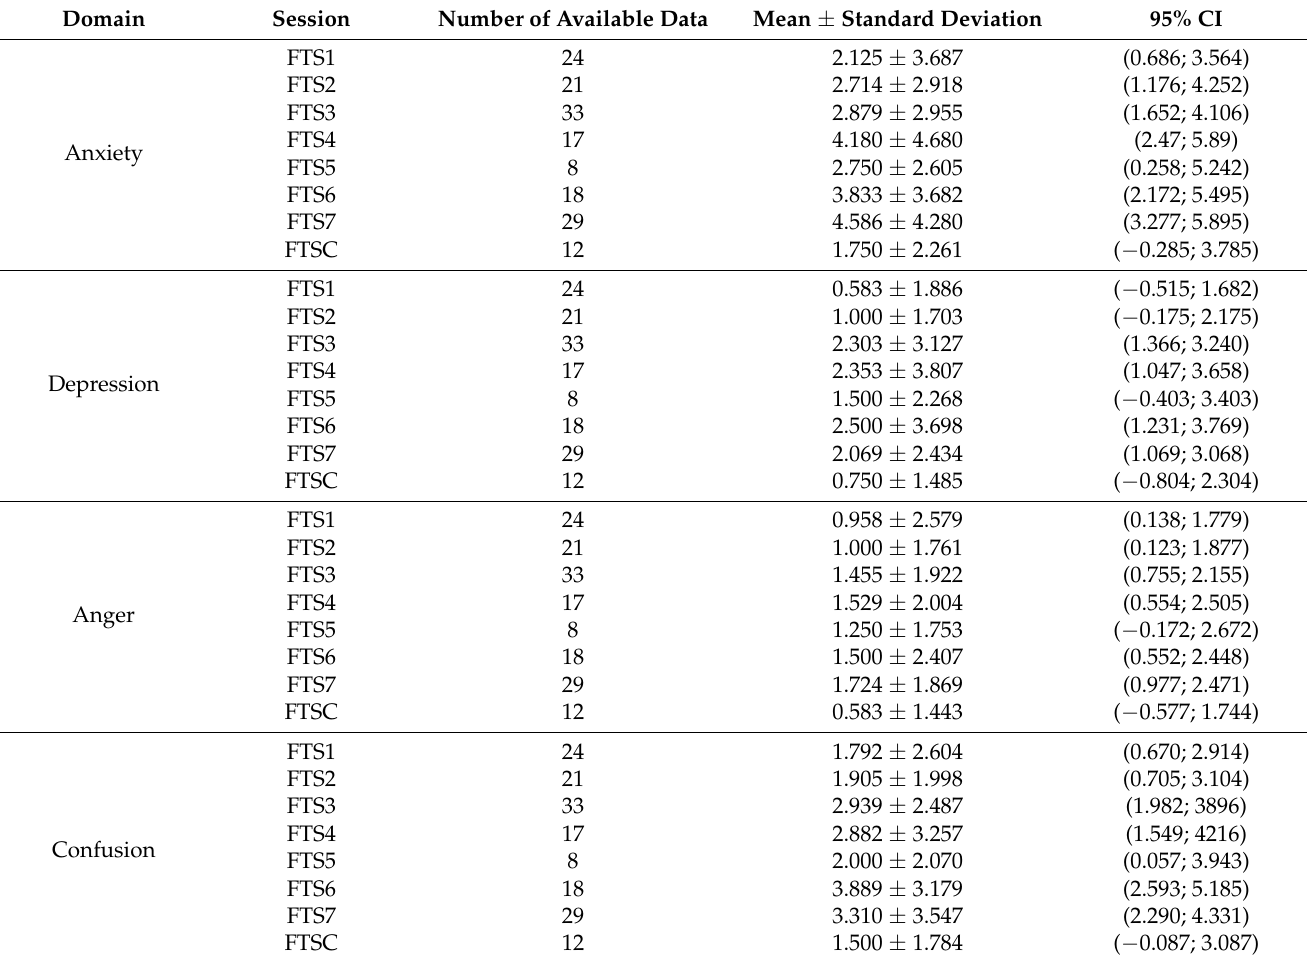
Table 3. POMS pre-intervention domain